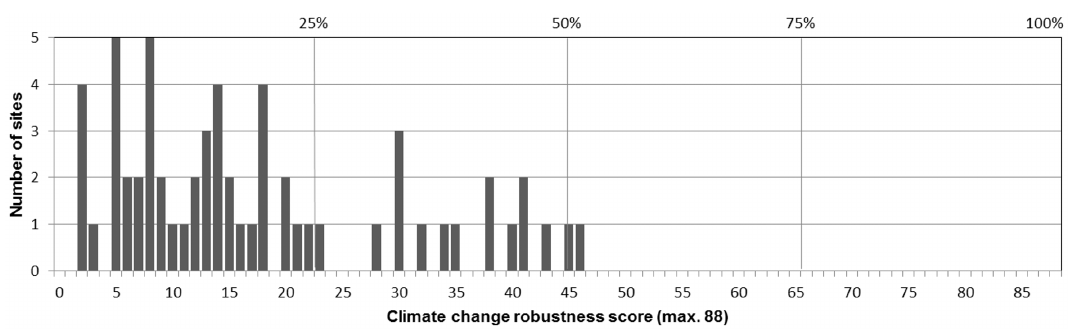
Fig 1. Distribution of climate change-robustness scores for the 60 protected areas analyzed. The climate change- robustness is the sum of the 44 individual scores for each management plan reachedby scoringall plans againsteach of the respective four criteria of each principle on a 0–2 scale. Mean value = 18, median= 14.